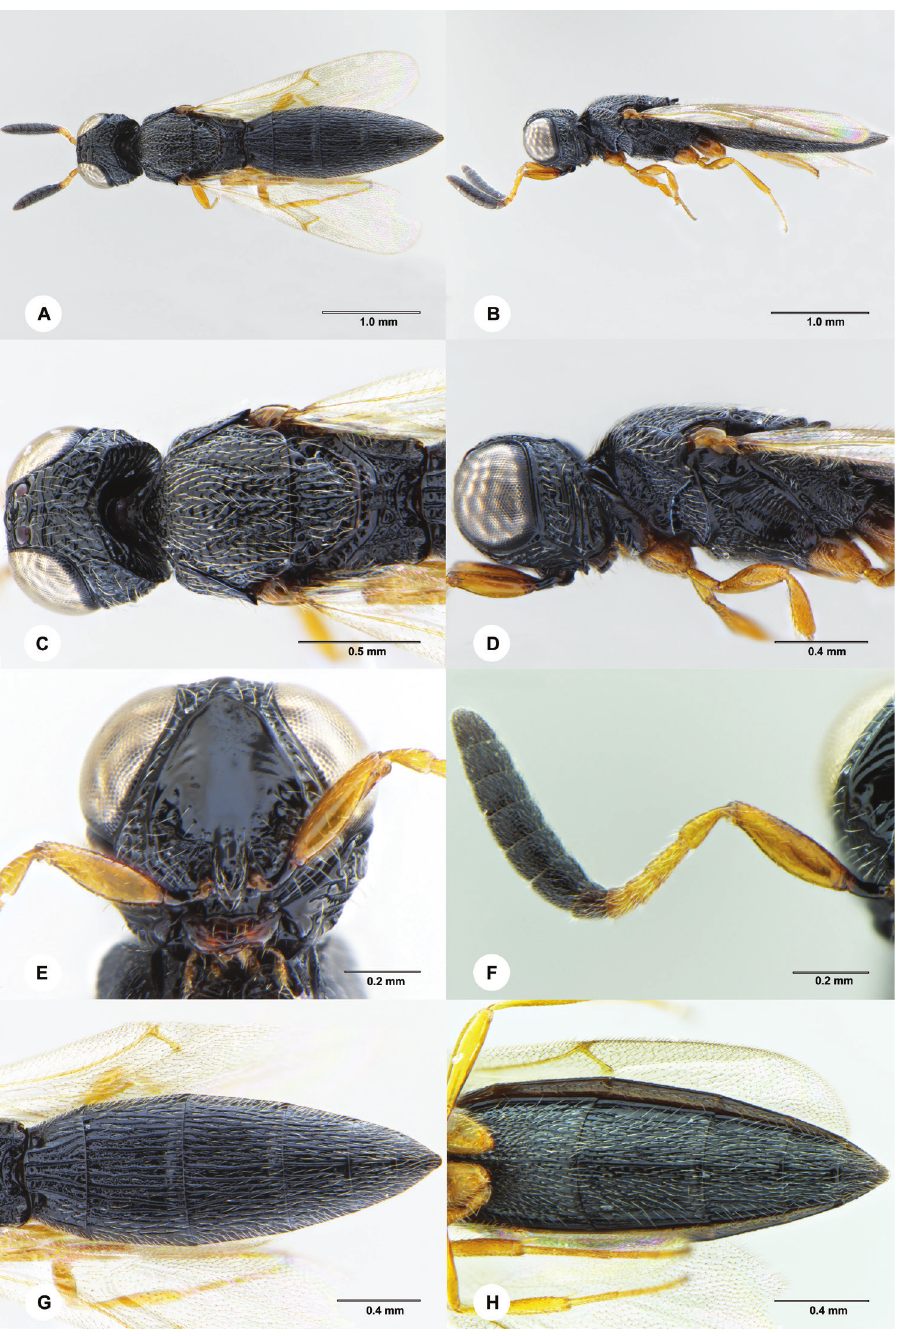
Figure 6. Oxyscelio striae Mo & Chen, sp. nov., holotype, female (SCAU 3048667) A dorsal habitus B lateral habitus C head and mesosoma, dorsal view D head and mesosoma, lateral view E head, anterior view F antenna G metasoma, dorsal view H metasoma, ventral